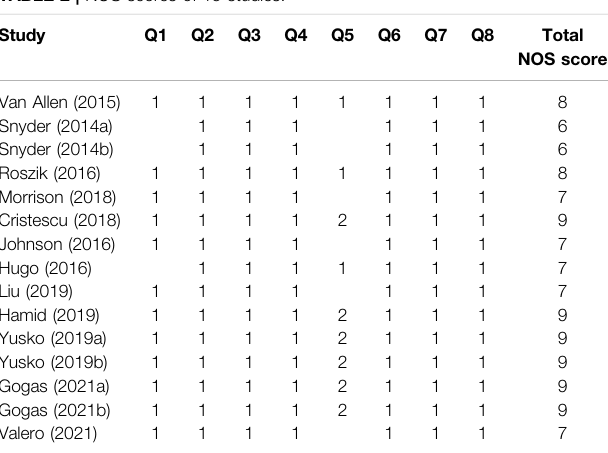
TABLE 2 | NOS scores of 15